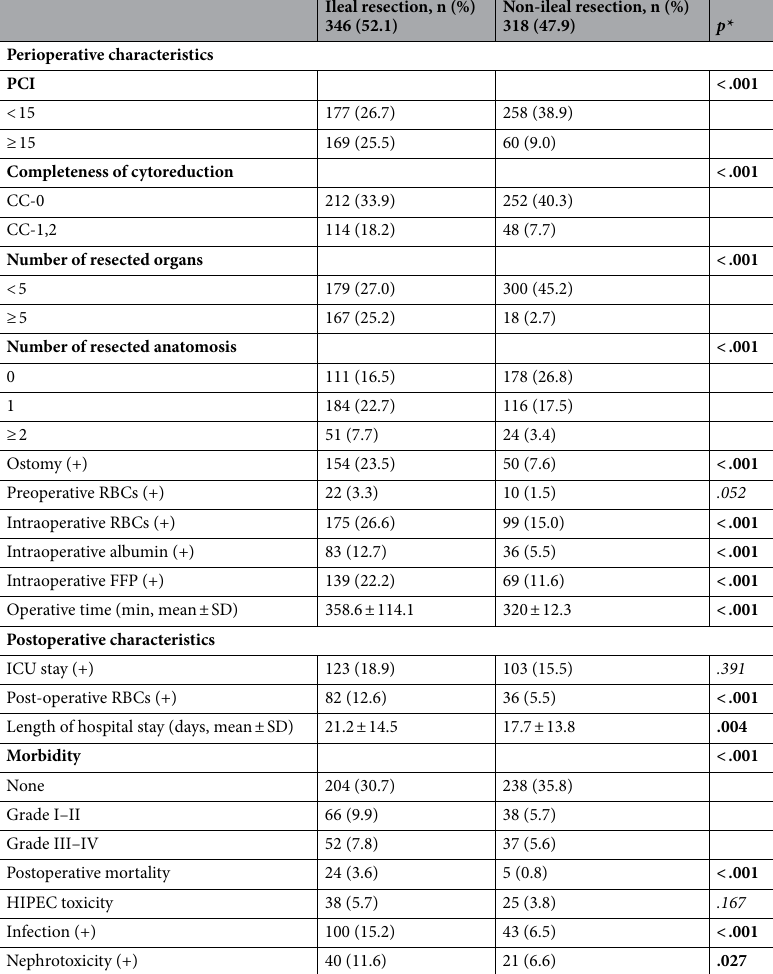
Table 2. Comparison of surgical characteristics between ileal resection and non-ileal resection groups. Bold values indicated statistical significance ( p < 0.005). PCI peritoneal carcinomatosis index, RBC red blood